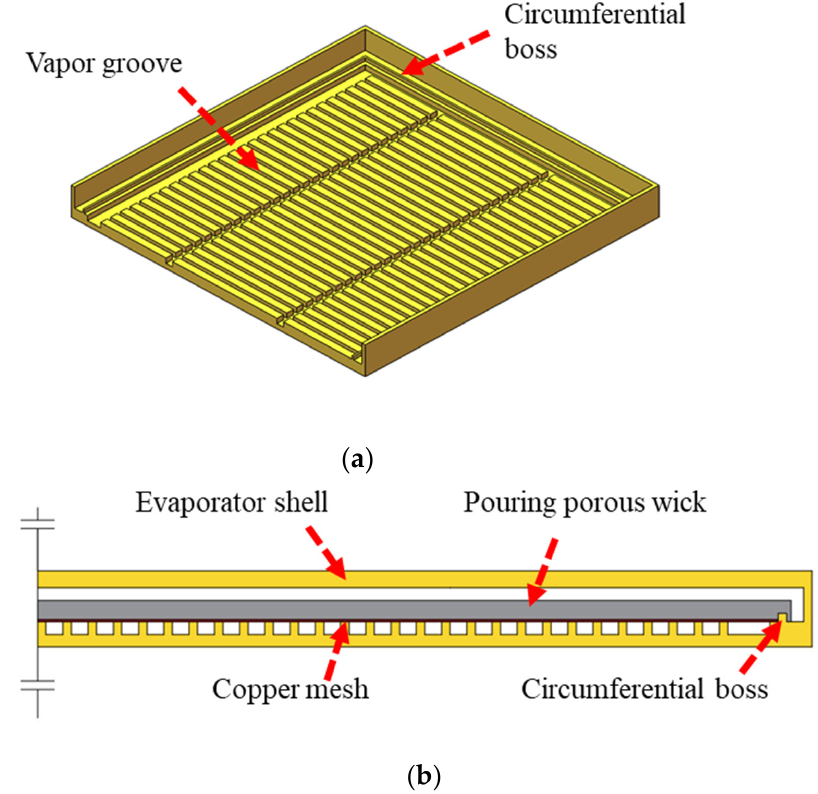
Figure 4. Structure of the evaporator. ( a ) Half shell of the evaporator ( b ) Cross-section after pour- ing